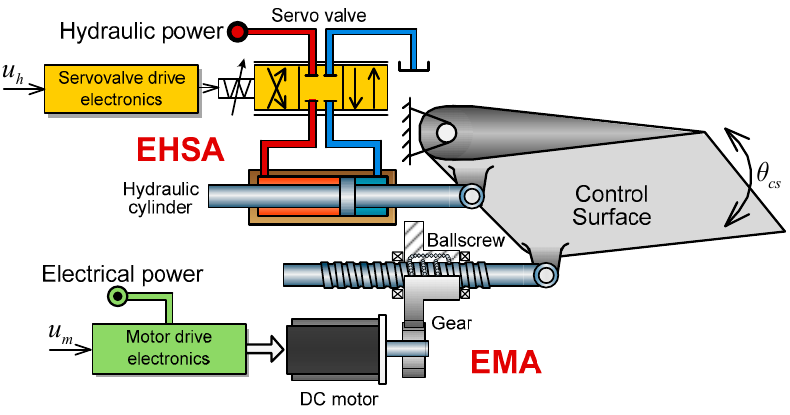
Figure 1. The structure diagram of hybrid actuation system.